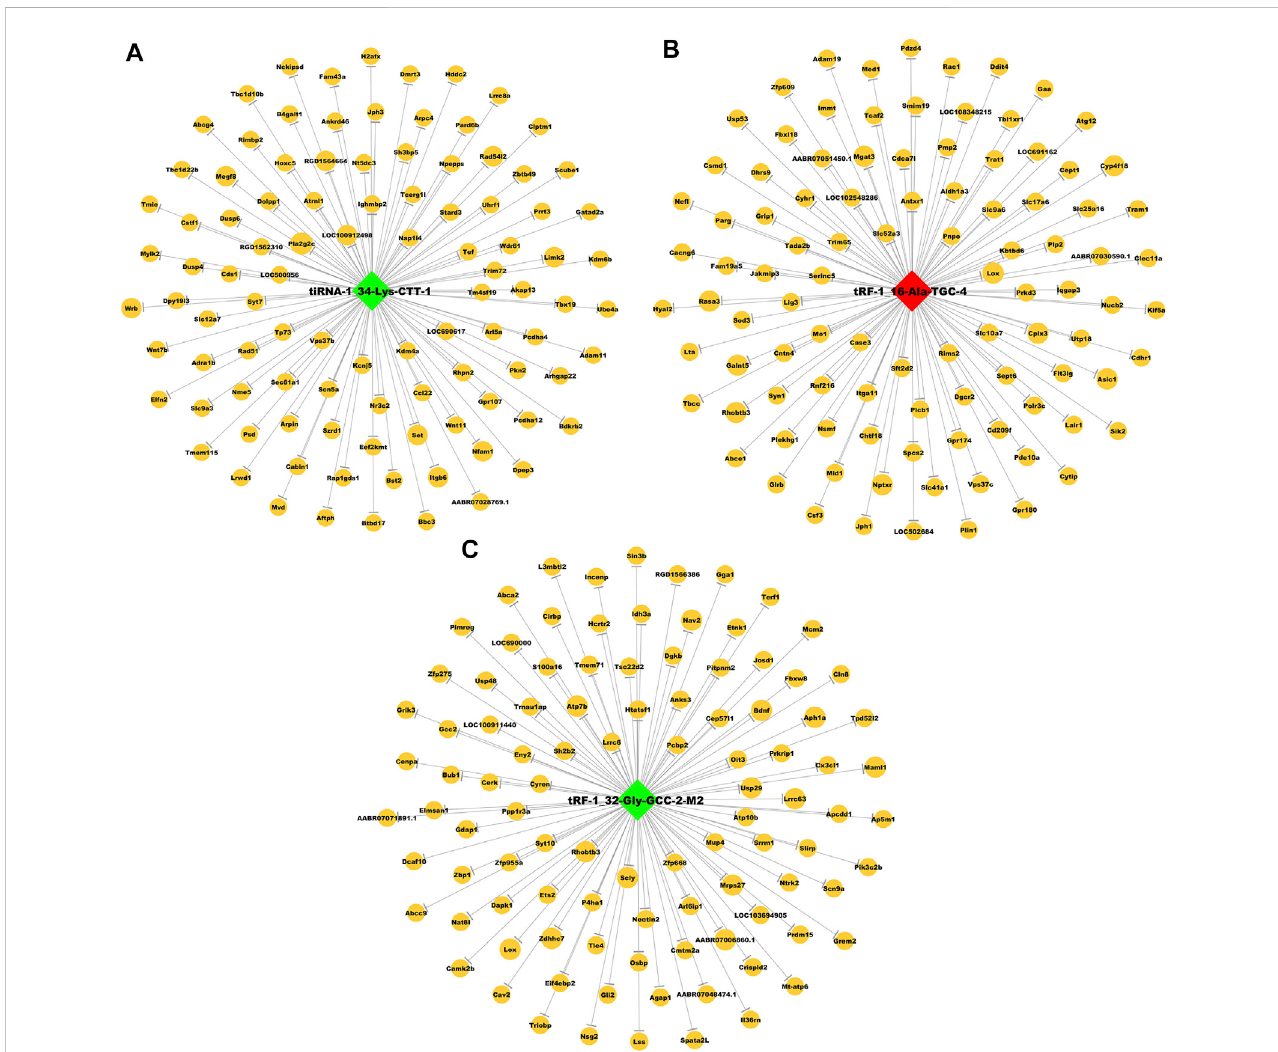
Predicted target mRNAs of three differentially expressed tsRNAs. The tsRNA/mRNA network analysis of (A) tiRNA-1-34-Lys-CTT-1, (B) tRF-1-16-Ala- TGC-4 and (C) tRF-1-32-Gly-GCC-2-M2. Nodes in green and red refer to downregulated and upregulated tsRNAs in sequencing, respectively, nodes in yellow are